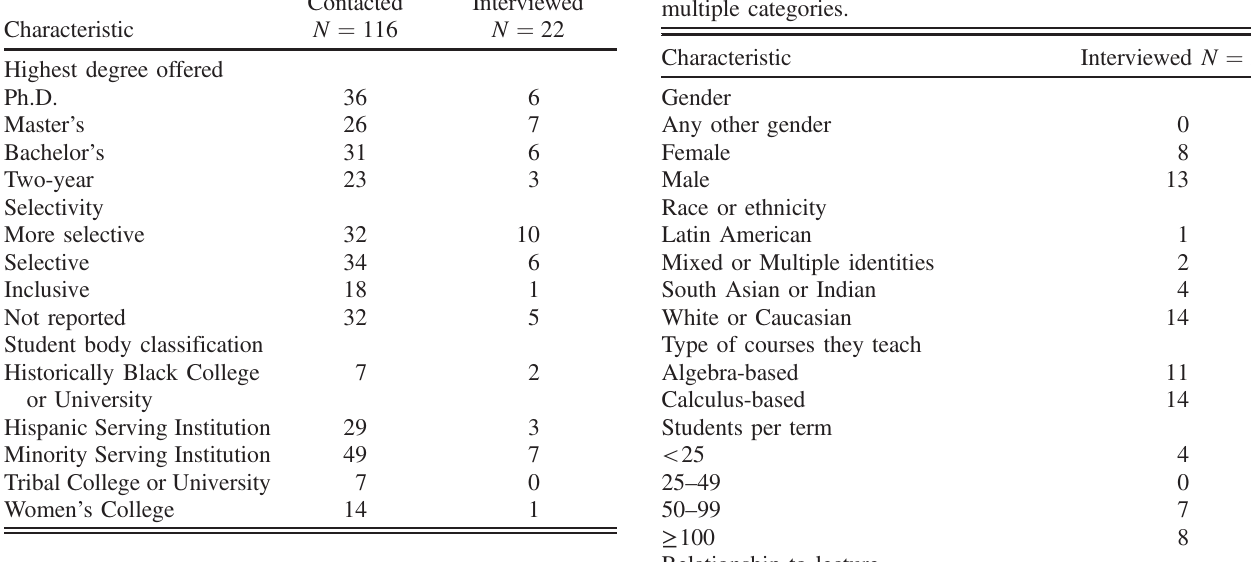
TABLE II. Self-reported information about the 22 instructors whom we interviewed, and the lab course(s) that they teach. Gender and Race or ethnicity categories emerged from the responses of these instructors. Not all instructors answered every question, and some answered with responses that fell into multiple